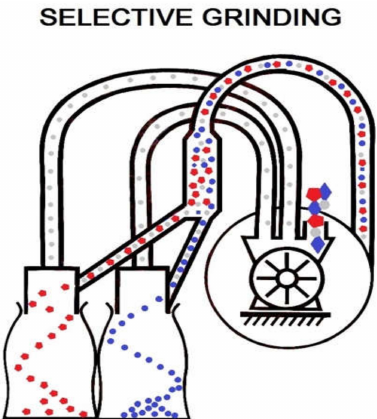
Figure 8. Schematic of selective grinding mode (material fractionation, author’s image).